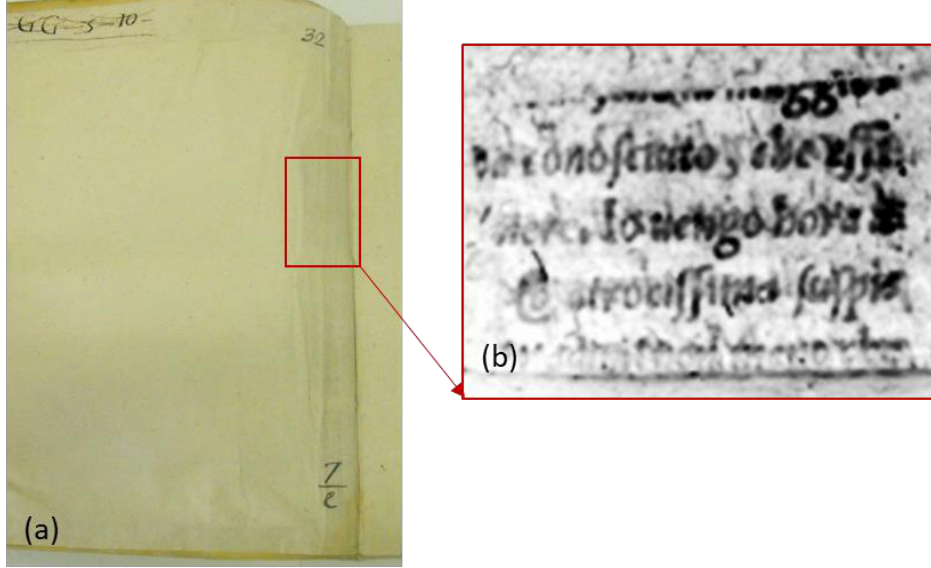
Figure 1. A 17th-century book, Biblioteca Angelica (Rome); ( a ) photo of the front end-leaf and ( b ) thermogram corresponding to the area marked by the rectangle in ( a ).